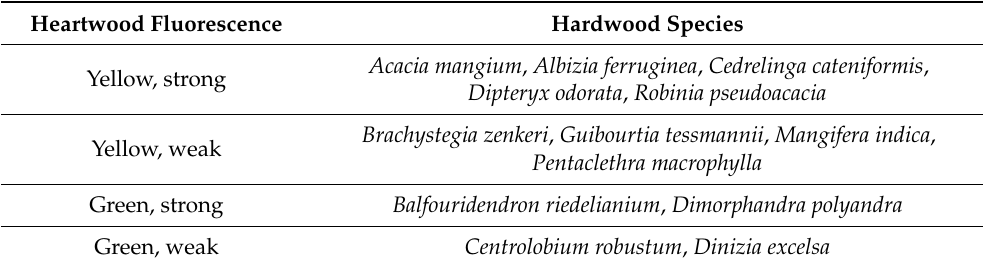
Table 20. Examples of species with different heartwood fluorescence. Heartwood